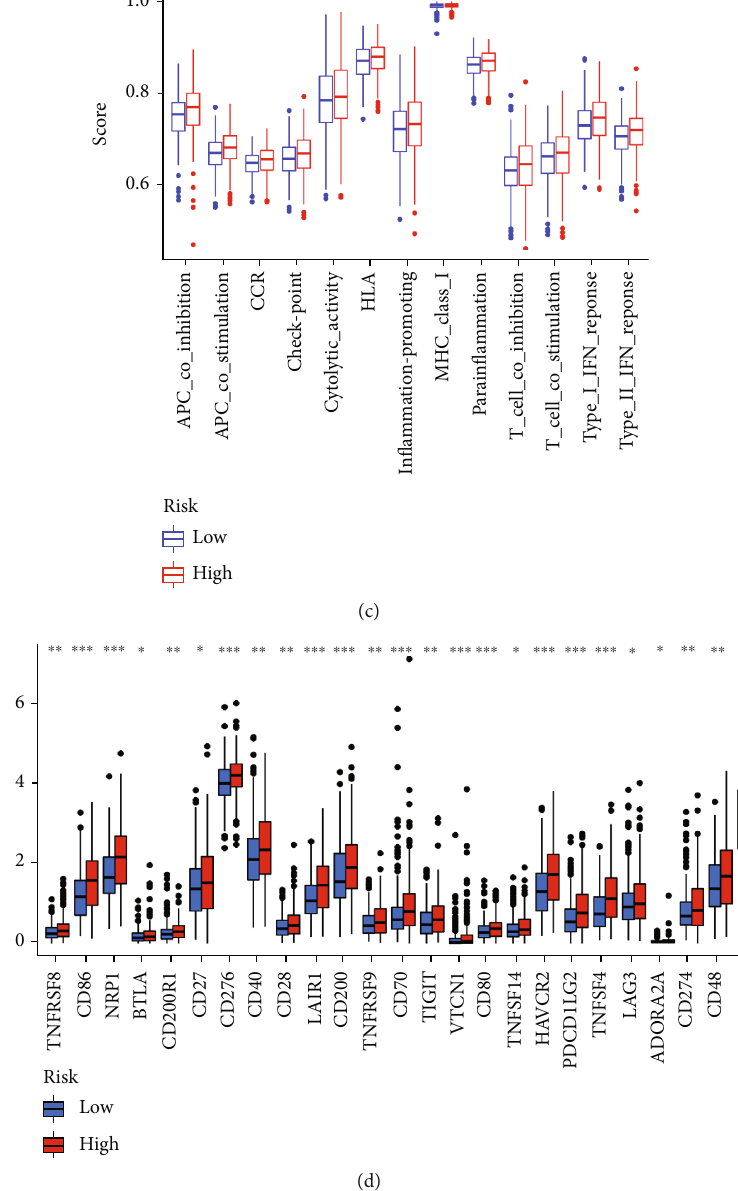
Figure 7: The investigation of tumor microenvironment and function. (a) The comparison of the stromal score, immune score, and ESTIMATE score between low- and high-risk groups. (b) The bubble and scatter diagrams showed correlation between risk scores and immune cells in fi ltration. (c) The box plot displayed the di ff erences of enrichment scores 13 immune-related pathways in high- and low- risk groups. (d) The box plot exhibited the di ff erences of 15 checkpoints expression in risk